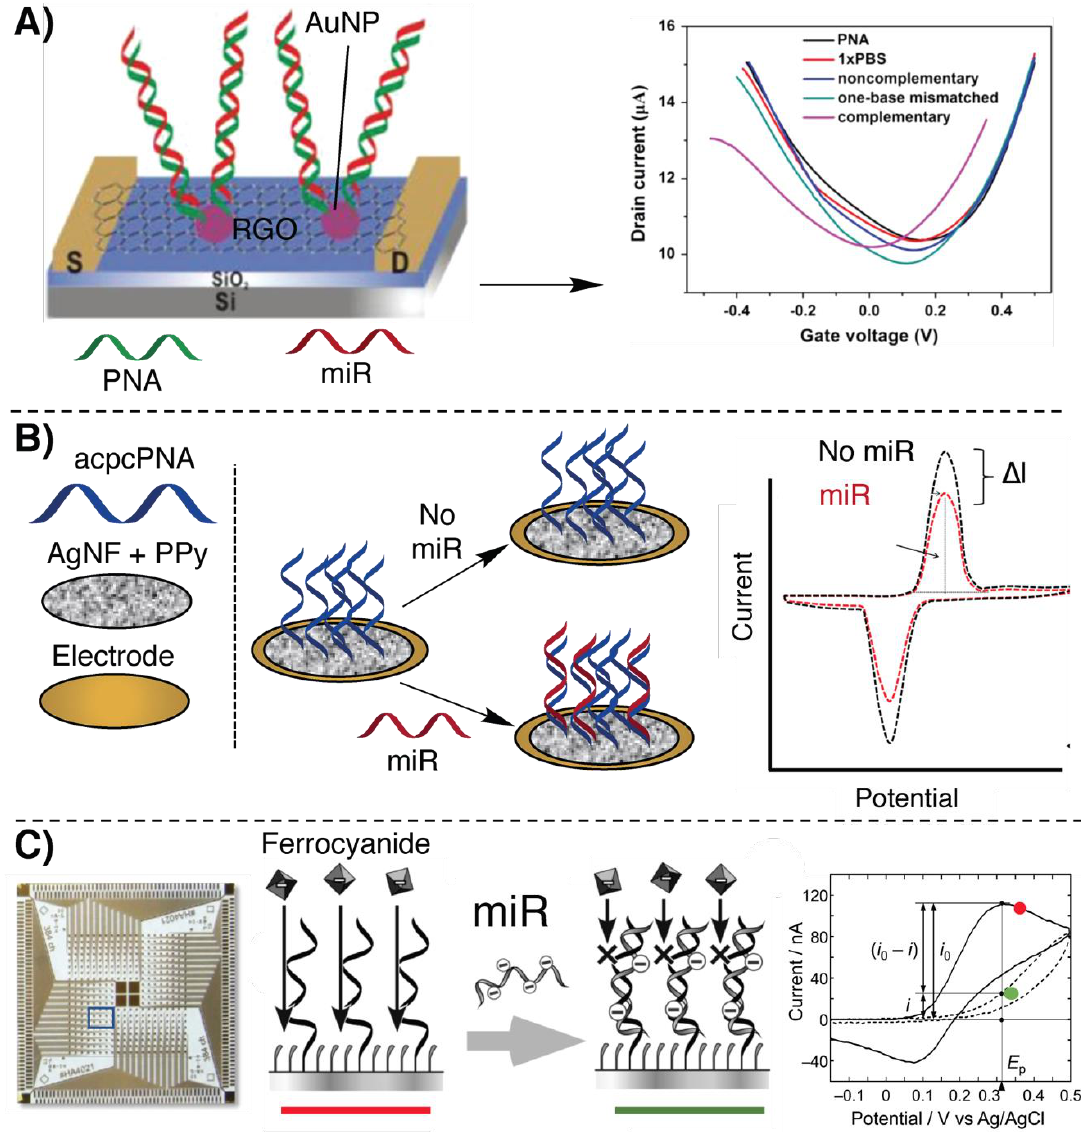
Figure 2. Illustration of some of the principal electrochemical methodologies based on hybridization for miR detection, relying on peptide nucleic acids (PNAs). ( A ) Field-effect transistor (FET)-based biosensor introduced in [59]. ( B ) Silver nanofoam (AgNF)-based biosensor decorated with acpcPNAs shown in [60]. ( C ) A 384-channel array on the Au/Cr surface based on the oxidation current of ferricyanide, described in [62].